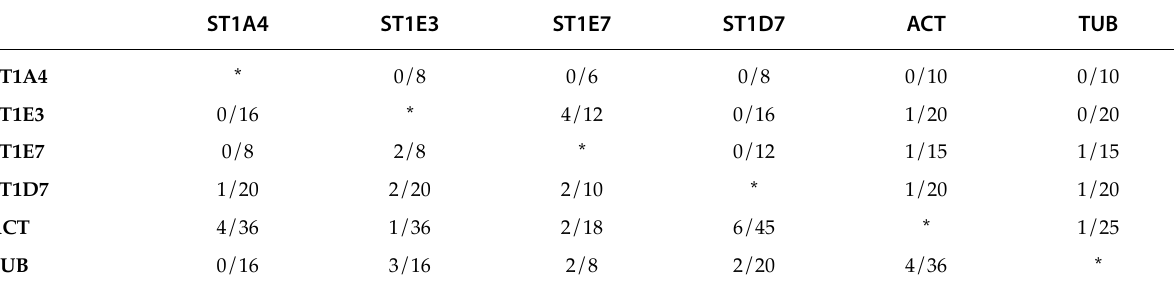
Table 2. Observed gametic disequilibrium revealed for Mycosphaerella graminicol a populations collected in 2005 (below the diagonal) and 2006 (above the